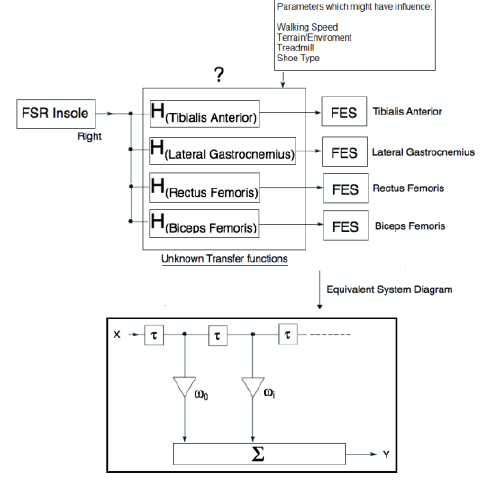
FIGURE 1: Flow diagram of the system.